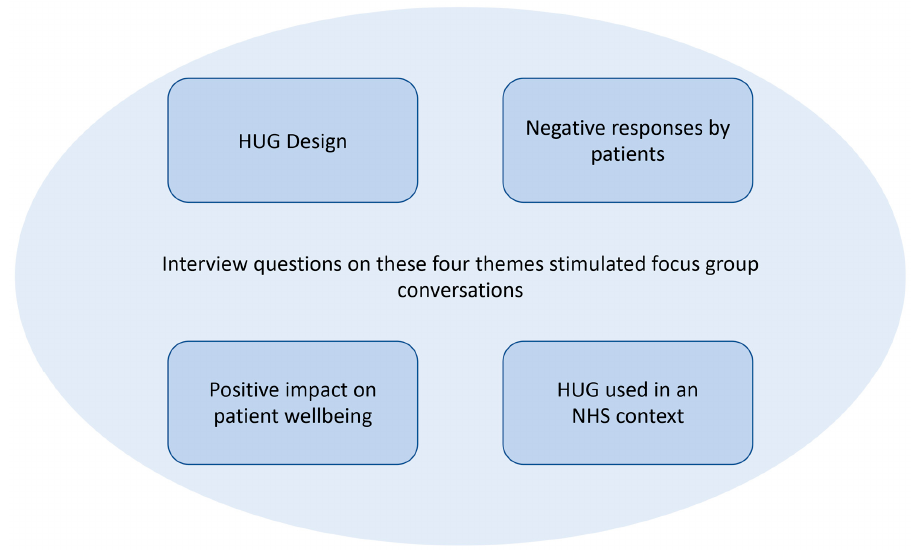
Figure 5. Themes identified to shape focus group questions and guide